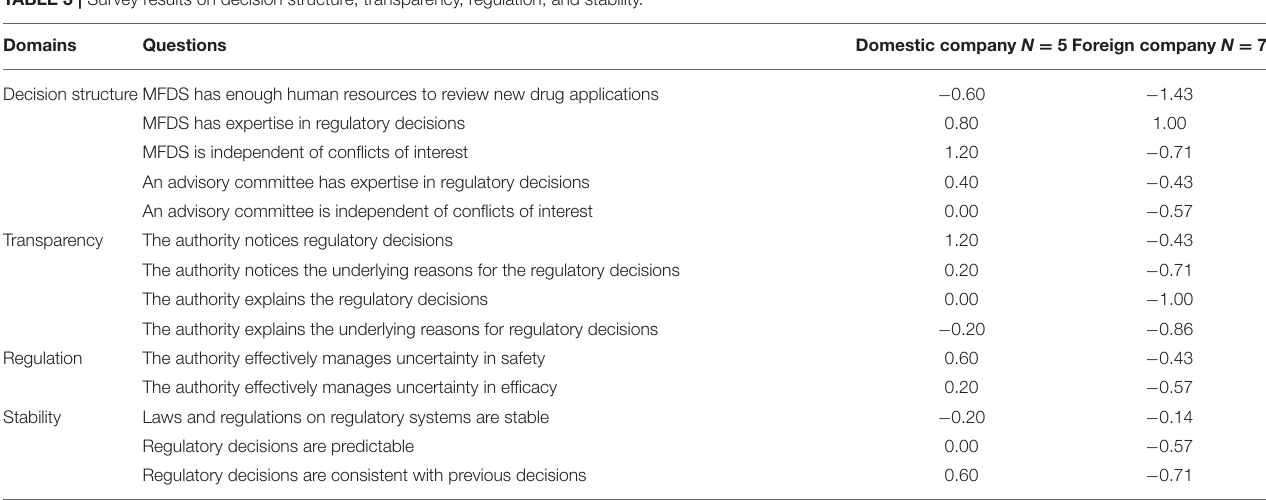
TABLE 3 | Survey results on decision structure, transparency, regulation, and